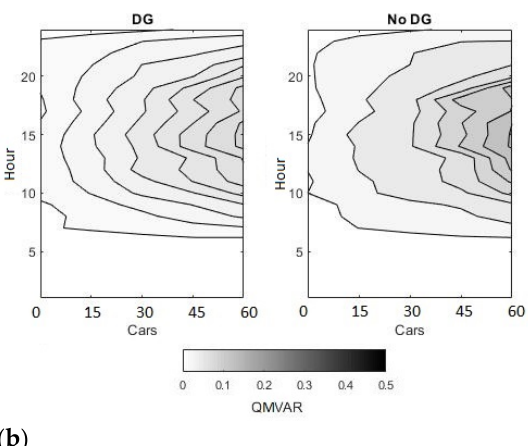
Figure 14. ( a ) Maximum active power requirements of the complete network. ( b ) Maximum reactive power requirements of the peak network.